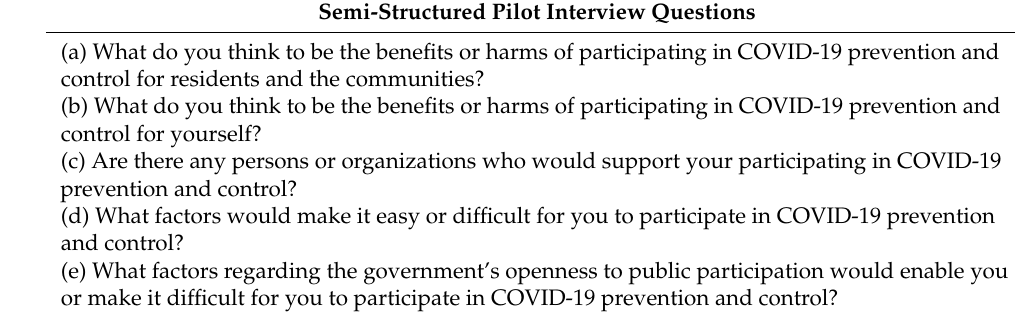
Table 1. Semi-structured pilot interview questions. Semi-Structured Pilot Interview